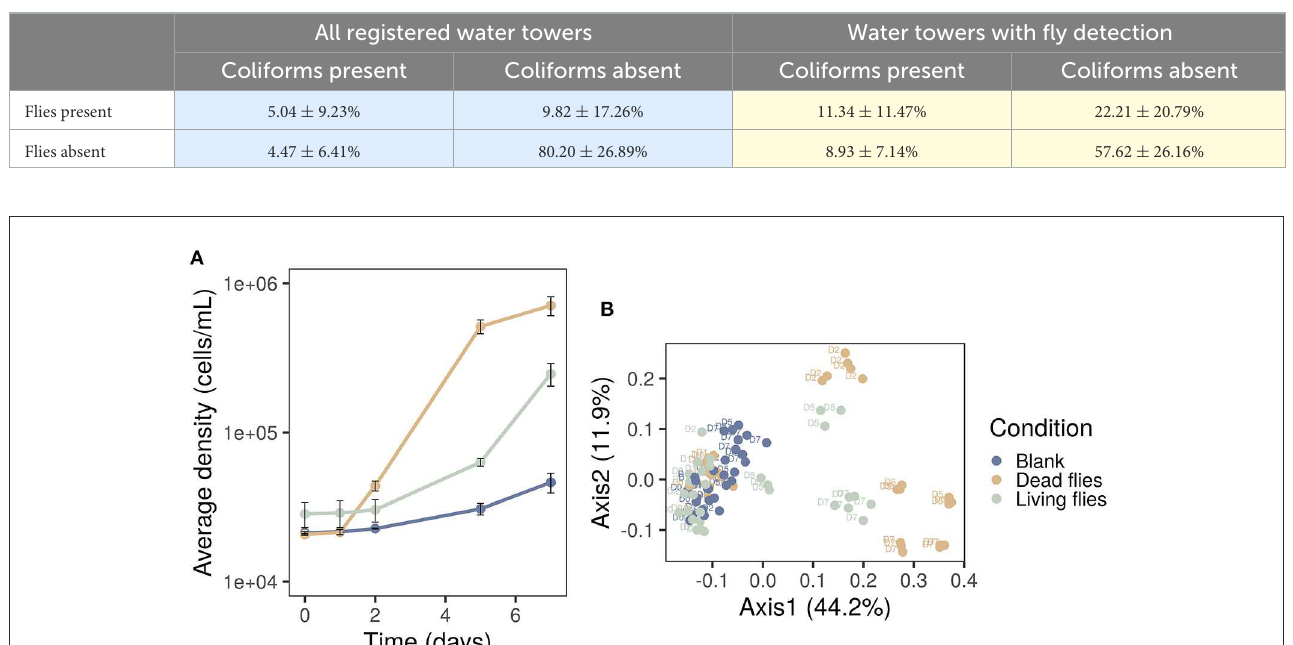
TABLE 3 Average percentage of presence and absence of flies and coliforms in all registered water towers ( n = 9) and in towers where flies were detected ( n = 4).